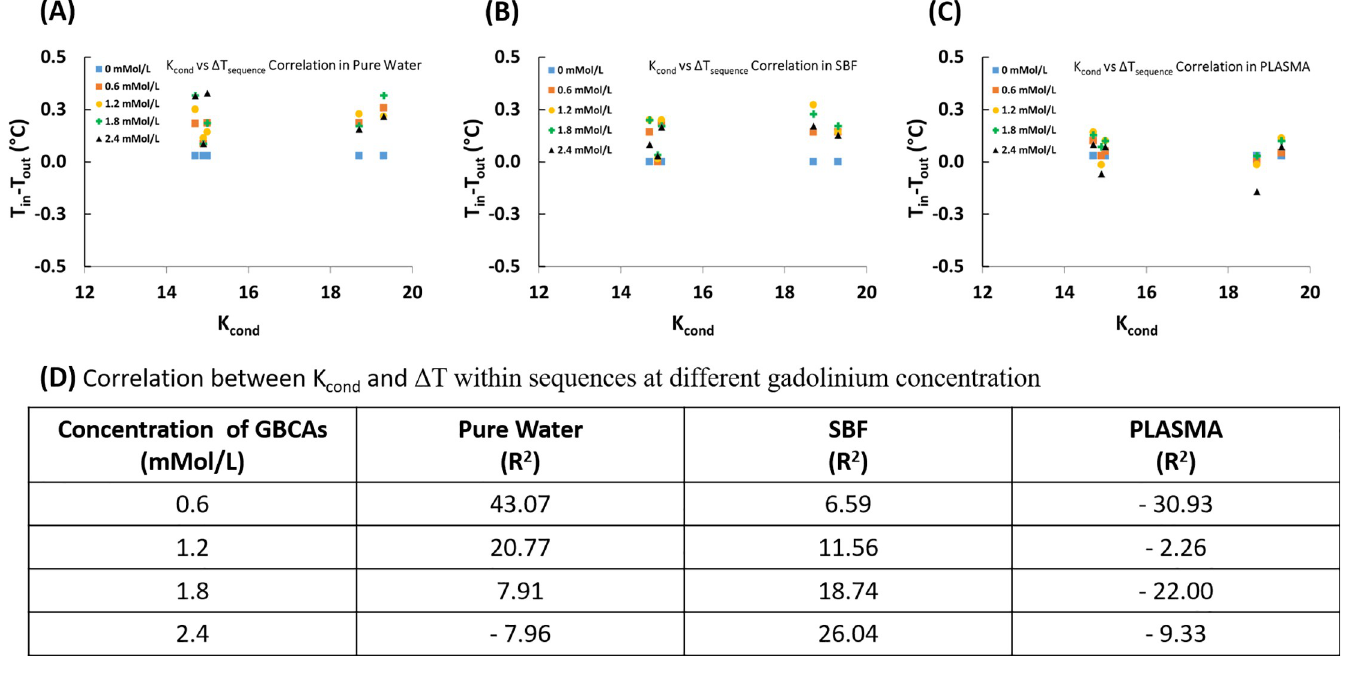
Fig 2. Scatter plots showing correlation between conditional stability constant (K cond ) and temperature difference ( Δ T sequence ) within a sequence in different media. (A) pure water, (B) Simulated body fluid-SFB, (C) plasma, and (D) relevant correlation coefficients.